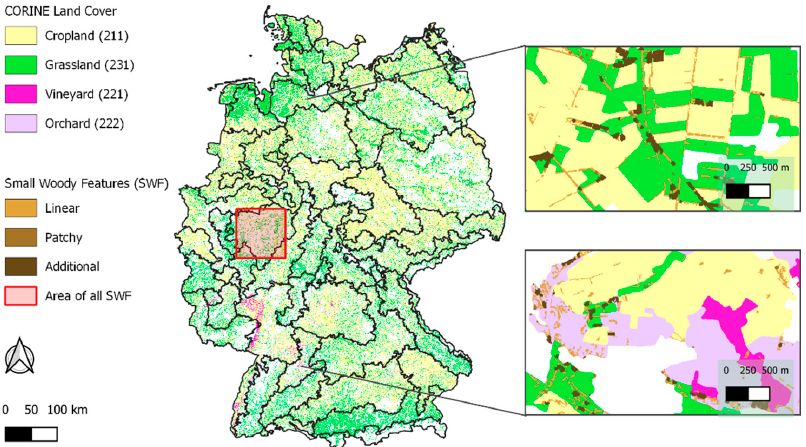
Figure 2. Distribution of SWFs (small woody features) across four agricultural systems. Linear SWFs covered the largest area, and patchy SWFs covered the least. The virtually superimposed red square denotes the total area covered by SWFs relative to the size of Germany. BKR = Boden–Klima–Räume (pedo-climatic regions). Data sources: GeoBasis-DE/BKG (Bundesamt für Kartographie und Geodäsie) CORINE Land Cover 5 ha CLC5 (2015), 2021; Copernicus Land Monitoring Service—High Resolution Layer Small Woody Features—2015 reference year, 2021. The pedoclimatic regions in the south and north-east had the lowest SWF cover (0– 3%) (Figure 3A). These regions were dominated by cropland (Figure 2). The pedoclimatic regions in the northwest dominated by grasslands had the highest SWF cover (7–8%) (Fig- ure 3A). Landscape structural change, i.e., increasing structural complexity arising from variable SWF cover, was primarily observed in the south, south-west, and central-east, i.e., the areas south of Berlin and north of Leipzig and Dresden, of the country (Figure 3B).